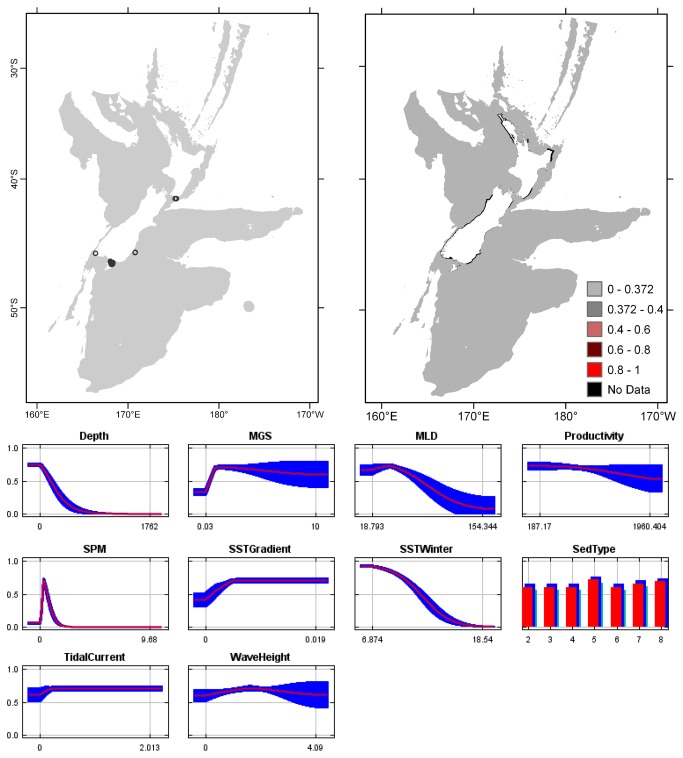

Hornerafoliacea

 known distribution (left), predicted suitable habitat (right), and fitted responses curves (marginal).For the predicted distribution, logistic probabilities less than the 10th percentile presence value indicated cells were unsuitable habitat. Probabilities of 0.4–0.6 indicated habitat suitability typical of the presence records, values of 0.6–0.8 and 0.8–1 indicated favourable and highly suitable habitat, respectively. Black cells had missing data in one or more environmental layer. Independent records are layed over the predictions. Marginal response curves show how the prediction changes for different values of each variable when all other variables were at their average sample value. Individual response curves are shown in Figure S3. For the categorical variable Sediment type: 1 = deep ocean clays; 2 = calcareous gravel; 3 = volcanic; 4 = calcareous mud; 5 = gravel; 6 = mud; 7 = sand; 8 = calcareous sand.